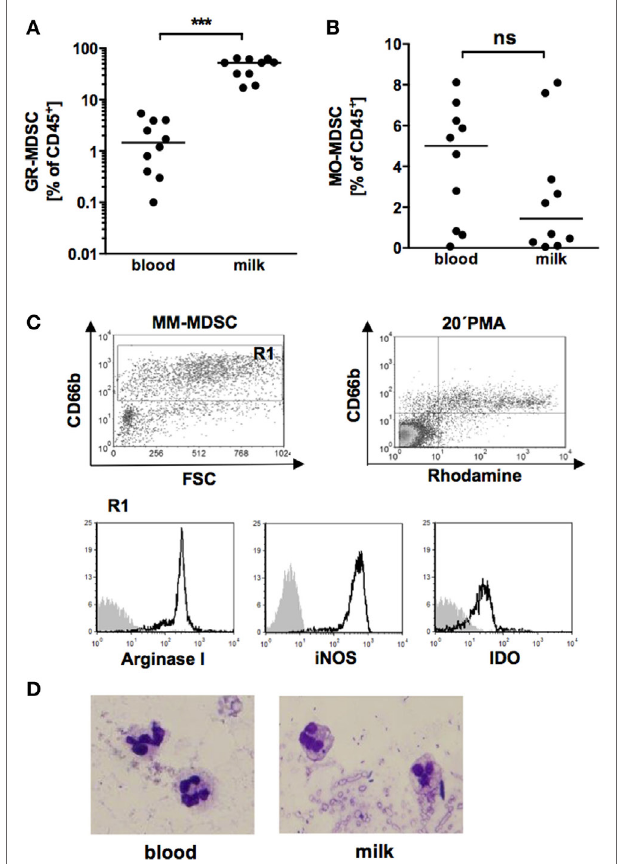
FigUre 1 | Quantification of granulocytic MDSC (GR-MDSC) and monocytic MDSC (MO-MDSC) in peripheral blood and breast milk (BM) of breastfeeding women. Mononuclear cells were isolated from peripheral blood of breastfeeding women and milk cells isolated from corresponding BM samples and analyzed by flow cytometry. (a,B) Scatter diagrams showing percentages of GR-MDSC (a) and MO-MDSC (B) from peripheral blood (blood) and BM (milk). Plots represent 10 independent experiments. Each symbol represents an individual sample and the median is indicated. *** p < 0.005; Wilcoxon matched pairs signed rank test. (c) Density plot of forward scatter vs. CD66b and Rhodamine vs. CD66b from CD45 + milk leukocytes. Gate 1 shows the GR-MDSC population. Representative histograms show the expression of intracellular effector enzymes ArgI, inducible NO synthase (iNOS) and IDO on GR-MDSC from BM. (D) Representative cytospin of GR-MDSC enriched from milk cells by